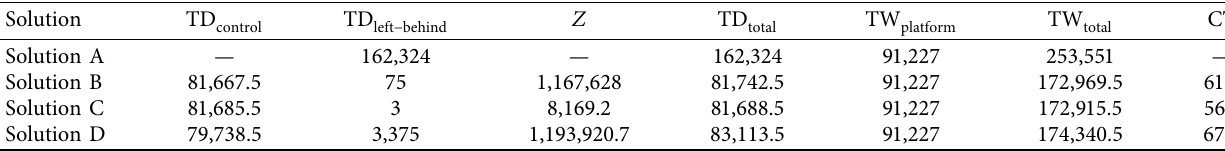
Table 17: Comparison of the results (unit: